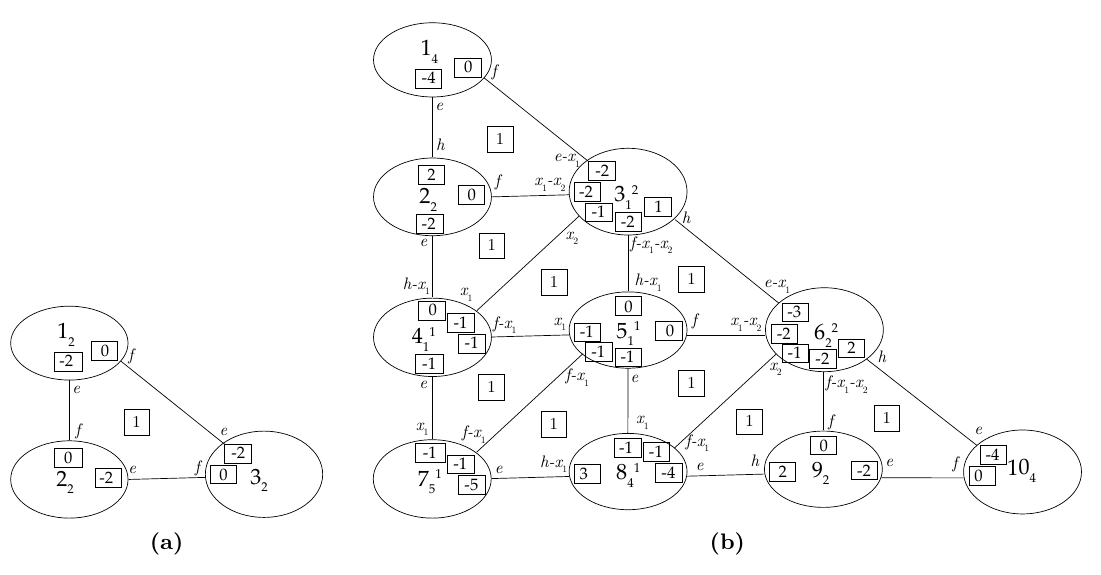
Figure 11 . The surface components of the theories: (a) B 4 , and (b) B 6